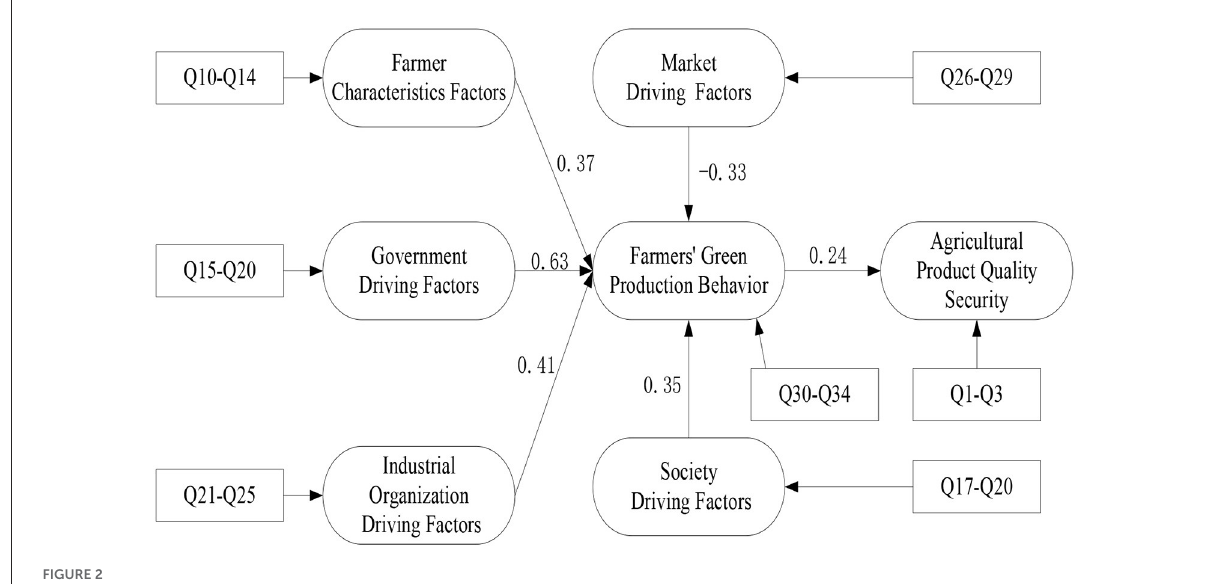
FIGURE2 Mediation effect